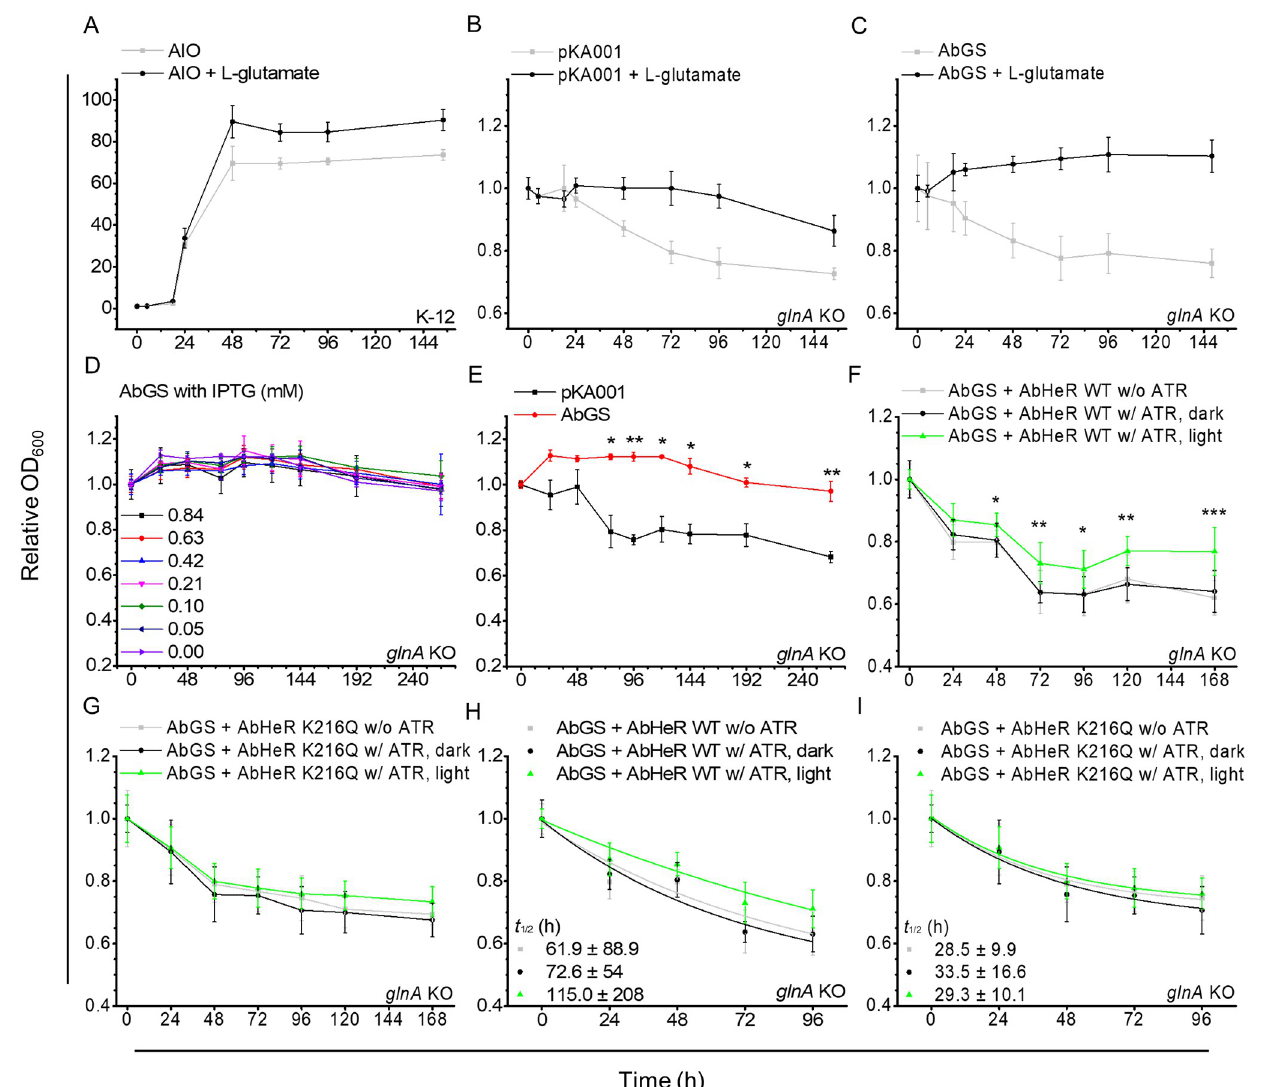
Fig 4. In vivo growth rate of E . coli glnA KO strains with AbGS and AbHeR. Cells are grown in LB medium and washed to remove components of the LB medium. The cells are then transferred to MOPS minimal medium. The growth of transferred cells was recorded at OD 600 at different time points; growth is normalized to the initial recording. The E . coli K-12 MG1655 strain transformed with AIO vector (A), glnA KO strain transformed with pKA001 null vector (B), and glnA KO strain transformed with pKA001-GS vector (C) were incubated in the absence and presence of L-glutamate in MOPS minimal medium containing IPTG, which regulates AbGS expression. (D–G) The E . coli glnA KO strain transformed with pKA001 null or pKA001-GS vector was incubated in MOPS minimal medium containing L-glutamate and glycerol (MOPS-GG). The E . coli glnA KO strain transformed with pKA001-GS-AbHeR WT (F) and K216Q (G) with and without ATR in the absence (dark) and presence of light (light, 532 nm) conditions at 40 μ mol m -2 s -1 were incubated in MOPS-GG medium. (A–E) The tests were performed in an independent experimental group ( n = 3). (F and G) The tests were performed in an independent experimental group ( n = 9). (E) Statistical significance between the 2 groups (pKA001 and AbGS) was analyzed using the t test; p -values are indicated with asterisks. (F and G) Statistical significance between the 2 groups (dark and light) was analyzed using the t test; p -values are indicated with asterisks. The data are expressed as mean ± standard deviation. Based on data (F) and (G), half-life ( t 1/2 ) for growth rate of cells was analyzed to quantify the effect of AbGS binding in the absence and presence of light by exponential decay. Nonlinear fitted lines are shown for AbHeR WT (H) and K216Q (I). Quantified t 1/2 values are indicated by the same color as that of each rectangle, circle, and triangle. The underlying data of the graph can be found in S3 Data. AIO, all-in-one; KO, knockout; LB, Luria–Bertani; WT, wild type.